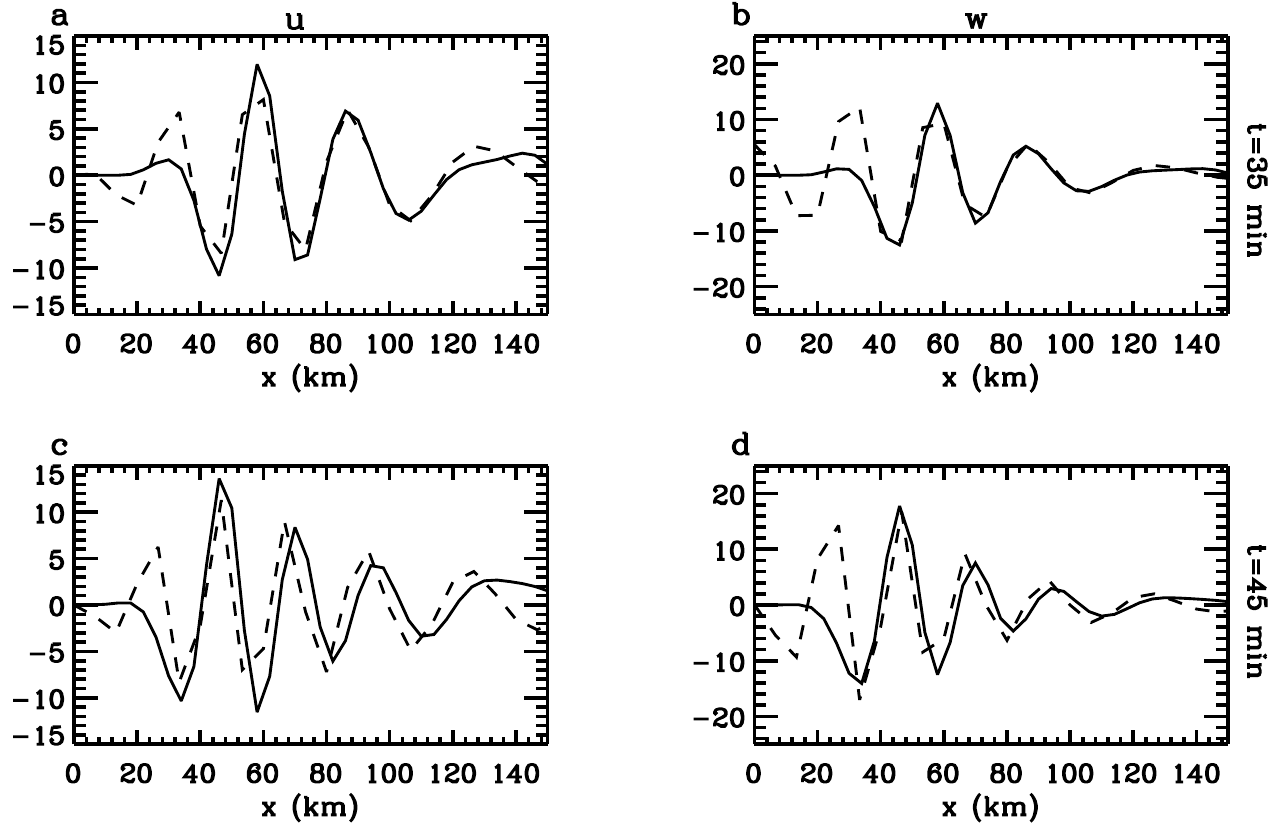
Fig. 19. Ray traced GW amplitudes as compared to FL amplitudes at z = 70km and y = 0. The first and second columns show the GW perturbation fields u and w , respectively. The upper and lower rows show the results at t = 35 and 45min, respectively. Solid lines show the ray trace results, while dash lines show the FL Boussinesq